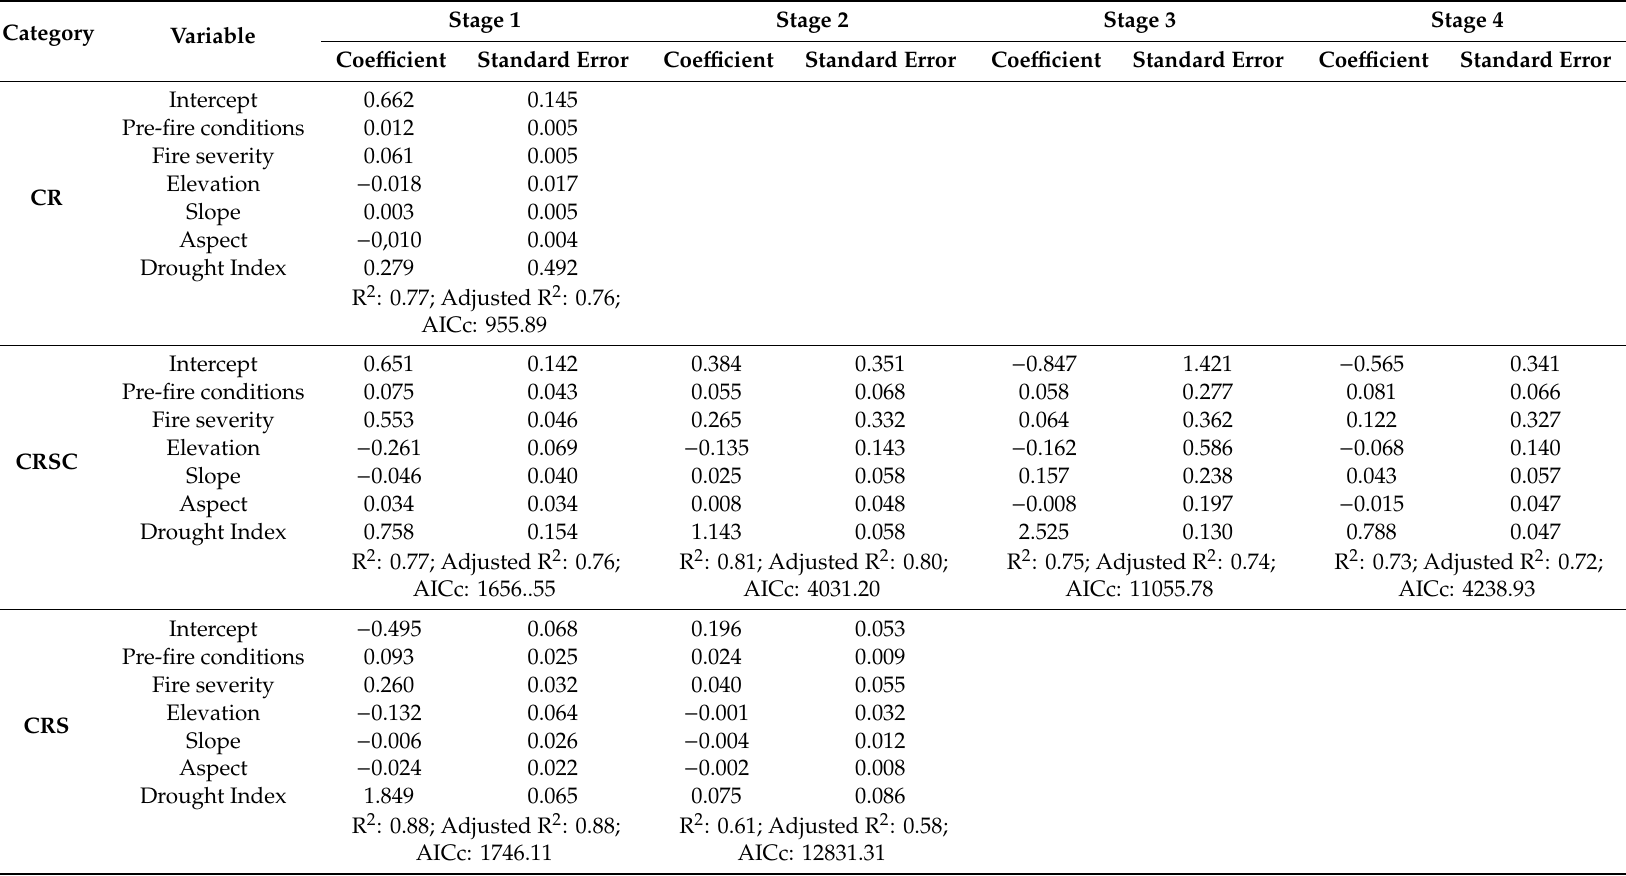
Table 4. Modeling results for Tasseled Cap Angle (TCA) recovery categories at each